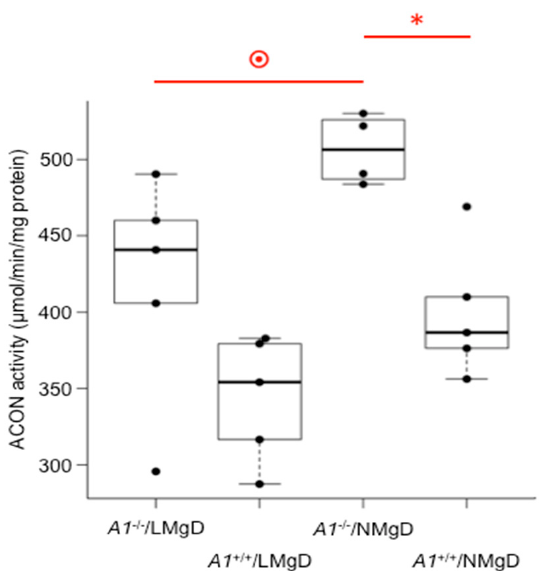
Figure A2. Post-hoc Tukey’s range test/CV. The CV activities presented as box-and-whisker plot overlaid with dot plot; dots represent raw input values for each analyzed group ( Slc41a1 − / − animals on LMgD, Slc41a1 +/+ animals on LMgD, Slc41a1 − / − animals on NMgD, and Slc41a1 +/+ animals on NMgD); ** p < 0.01, *** p < 0.001. Abbreviations: A1 , Slc41a1 ; CV, complex V; LMgD, low Mg diet; NMgD, normal Mg diet.